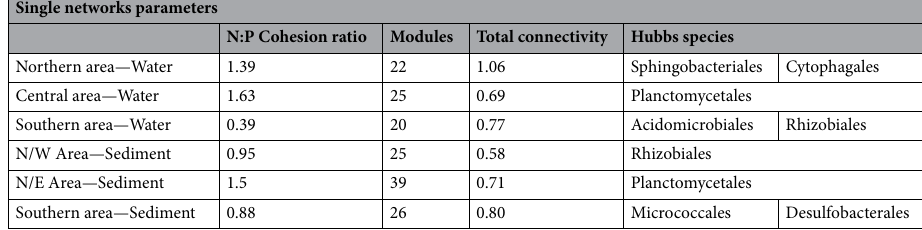
Table 2. The table represents the parameters of Networks of the single Area, in terms of negative to positive cohesion ratio (N:P), Modules, Total connectivity and hubbs order of the Network, both for pelagic microbiome (first three rows of the table) and sediment microbiome (last three rows of the